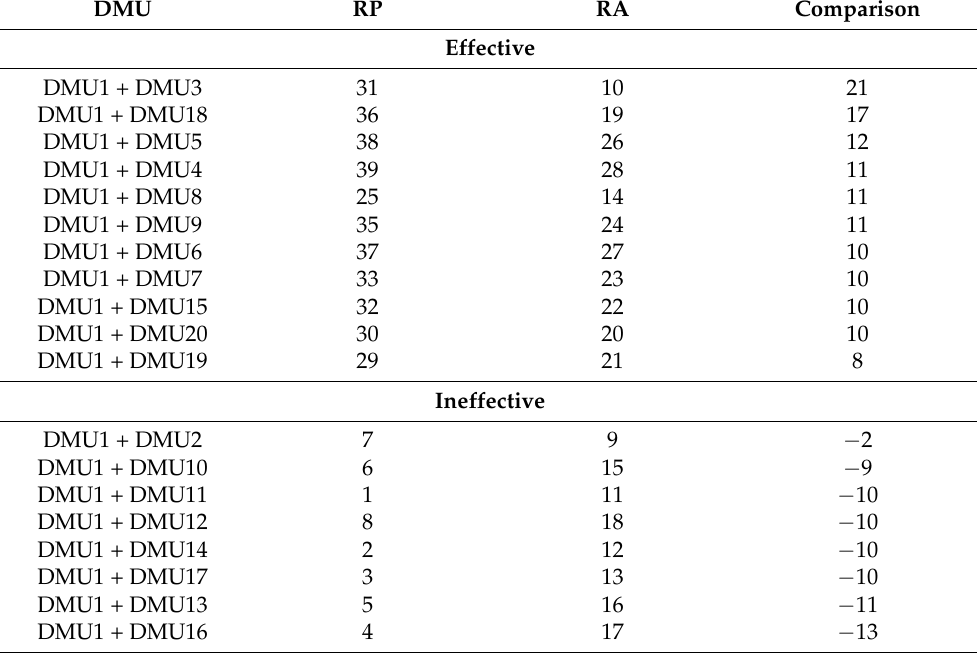
Table 11. The effective and ineffective alliance